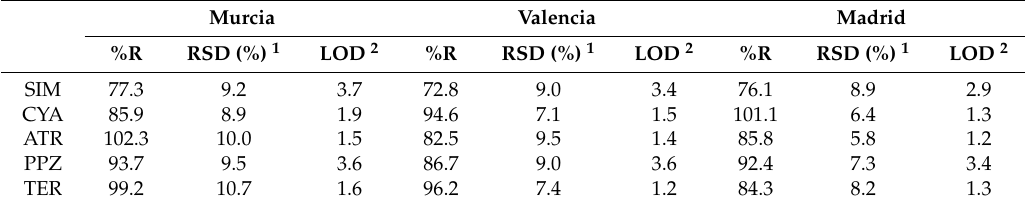
Table 1. Analytical performance and application of HFM-protected-MI-MSPE for the determination of triazines in soil sample from different origin.